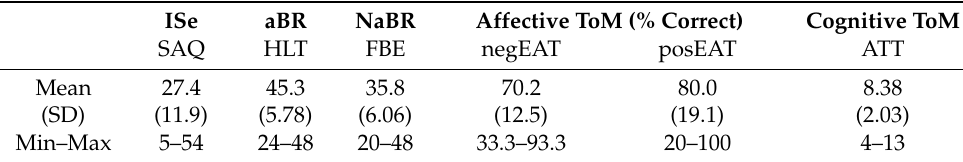
Table 1. Descriptive statistics for questionnaires and tasks used in the study. ISe aBR NaBR Affective ToM (% Correct) Cognitive